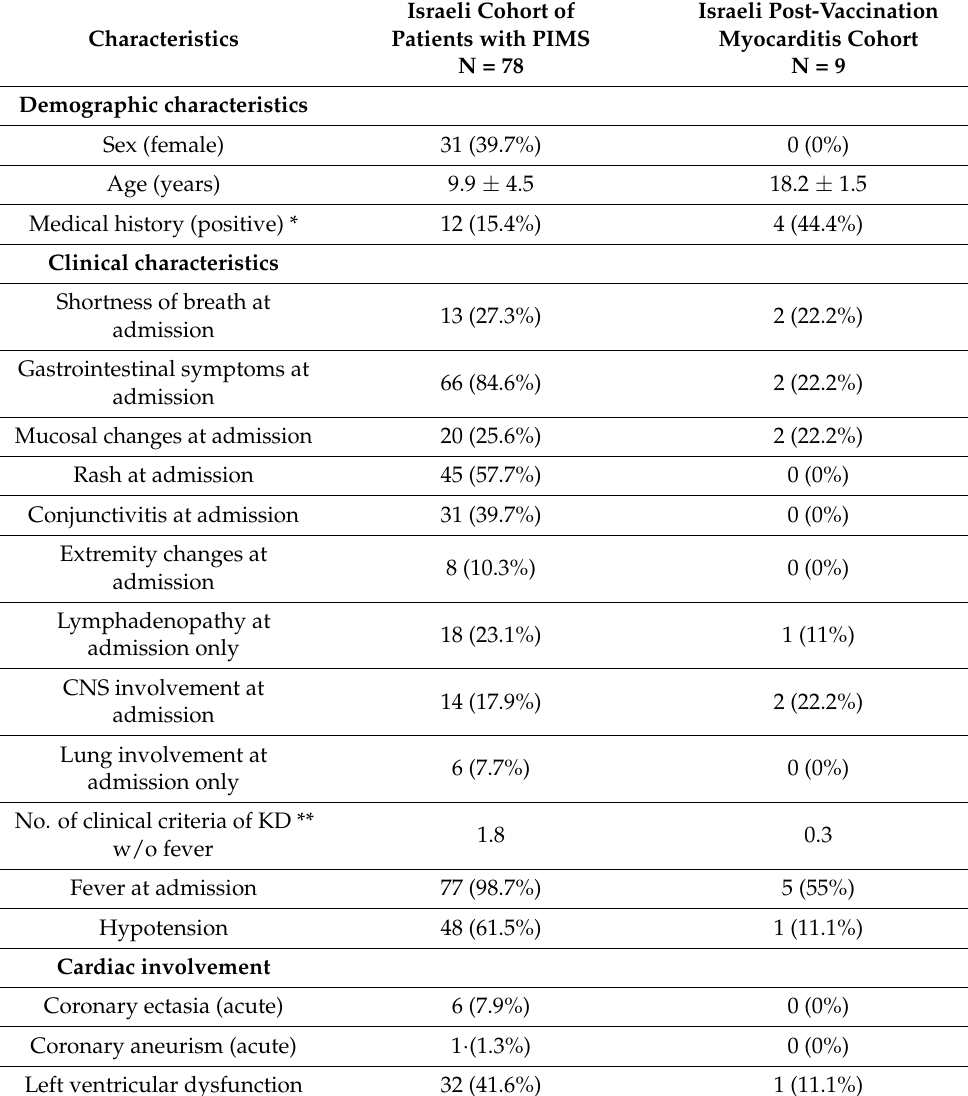
Table 2. Clinical and laboratory data for 78 patients with pediatric multisystem inflammatory syndrome (PIMS) and 9 patients with post-COVID vaccination myocarditis in Israel. Israeli Cohort of Israeli Post-Vaccination Characteristics Patients with PIMS Myocarditis Cohort N = 78 N = 9 Demographic